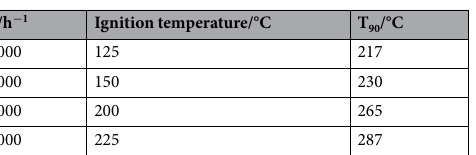
Table 1. Ignition temperature and T 90 of ethyl acetate oxidation with different space